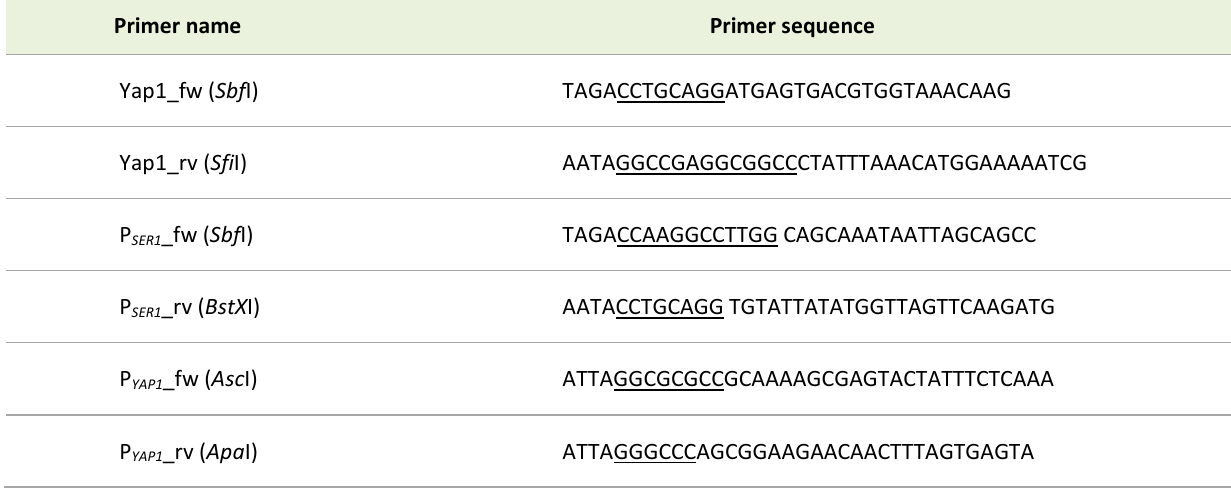
TABLE 2. Primers used for generation of YAP1 overexpression and knock